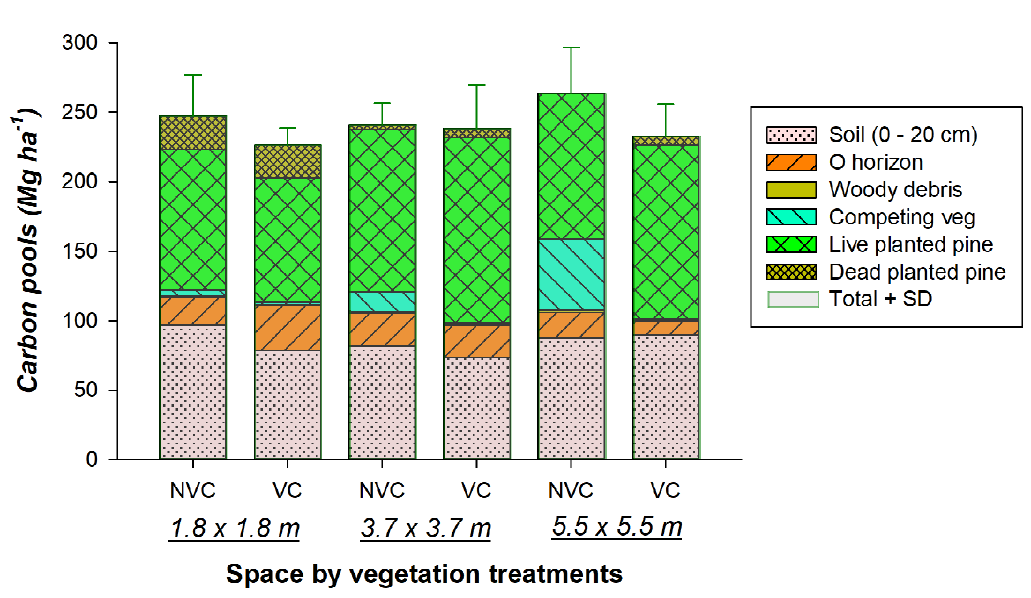
Figure 5. Age 54 total ecosystem carbon among pools in ponderosa pine plantations (as in Figure 3) under combinations of understory vegetation control (VC) and non-control (NVC) and three different levels of planting spacings at Challenge Experimental Forest, California,